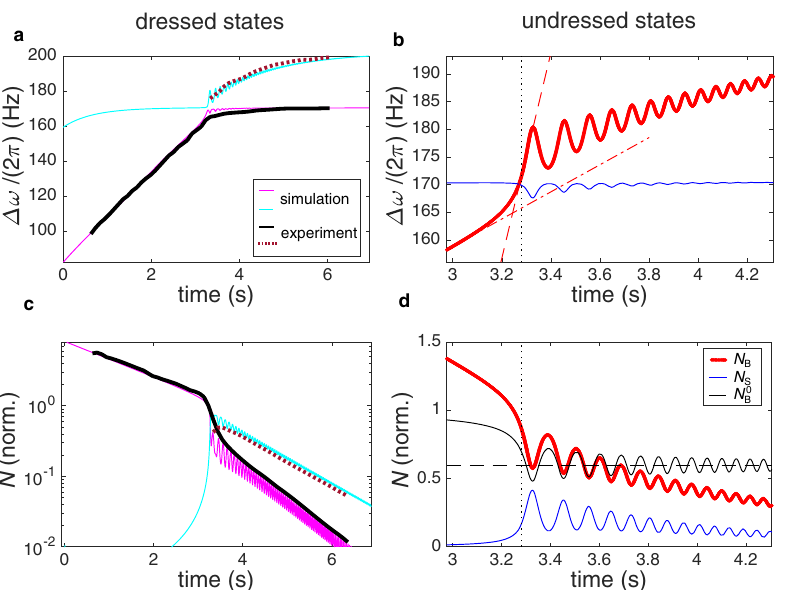
Fig. 4 Analysis of two-level dynamics at small N B . a The dressed ground level time crystal frequency in the simulation (thin magenta line) follows that extracted from the experiment (thick black line). The experimental line is obtained by tracing the maximum in the Fourier spectrum shown in Fig. 3 (oscillations are fi ltered out by the long time window). The ground state frequency initially corresponds to ω B , and after the avoided crossing at t = 3.3 s it corresponds to ω S . Simultaneously, the excited level frequency (simulation - thin cyan line, experiment - dotted thick dark red line) switches from ω S to ω B . Oscillations of the frequencies after the crossing arise owing to the population oscillations. b We can hence use the simulation to extract the undressed frequencies ω B (thick red line) and ω S (thin blue line), which cross at t = 3.3 s (dotted vertical line). The crossing rate d ∣ ω S − ω B ∣ /d t ≈ d ω B /d t is accelerated intrinsically by the feedback ω B ( N B ), as illustrated by the different slopes of the dash-dotted and dashed red lines. The Landau-Zener population transfer magnitude is determined by this speed-up. Frequencies are plotted in the rotating frame Δ ω = ω − ω 0 . The corresponding populations are shown in the panels below: c The measured signal amplitude (ground level - thick black line, excited state - dotted thick dark red line) agrees with the simulated dressed populations (ground level - thin magenta line, excited state-thin cyan line). Both the total population from simulation and the measured signal are normalised to one at the crossing, and the fi lling factors applied for comparison in Fig. 3 (see Methods) are not used here. d The undressed populations N B (thick red line) and N S (thin blue line) are extracted from the simulation. The total population is normalised to one at the crossing. The black line shows the ¼ N Þ = N ð t ¼ 0 Þ . After the crossing, the compensated bulk population averages at bulk population with the exponential decay compensated, N 0 exp ð t = τ B B B B N 0 ¼ 0 : 61 (horizontal dash line), corresponding to the fraction of population transferred to the excited state by the Landau-Zener B